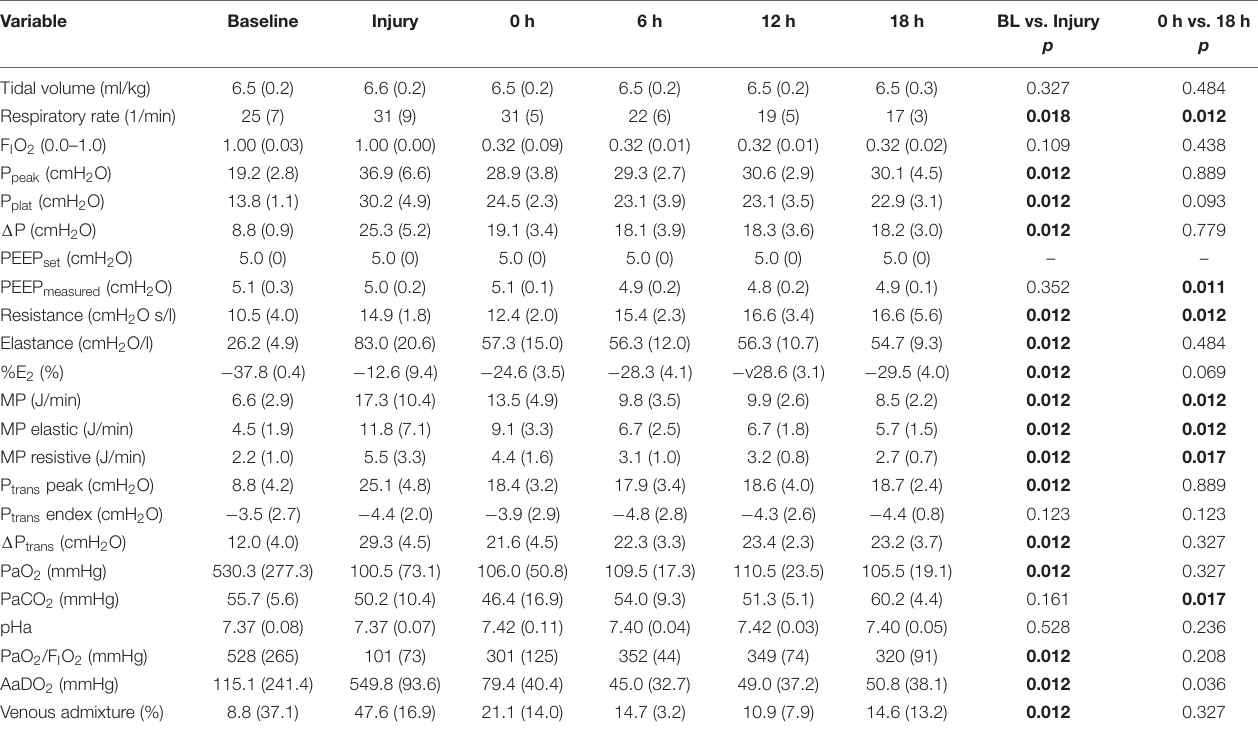
TABLE 1 | Respiratory